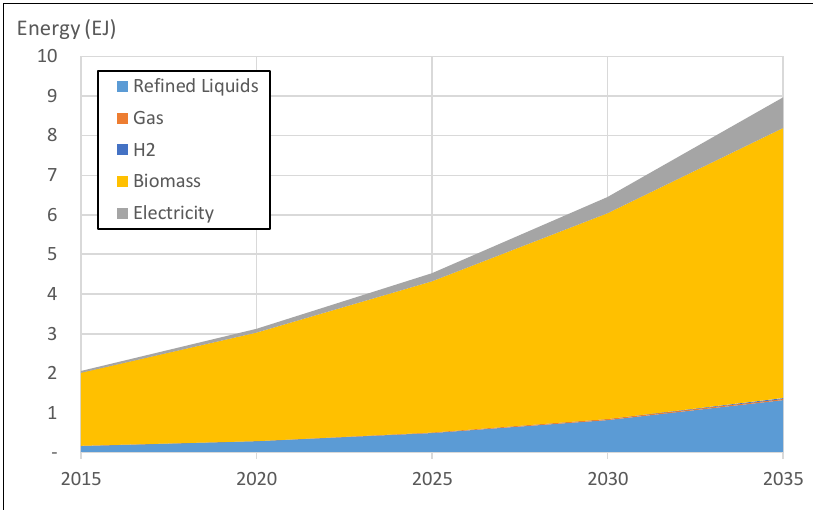
Figure 5. Final Energy Demand for the Reference Case (Unit: EJ).